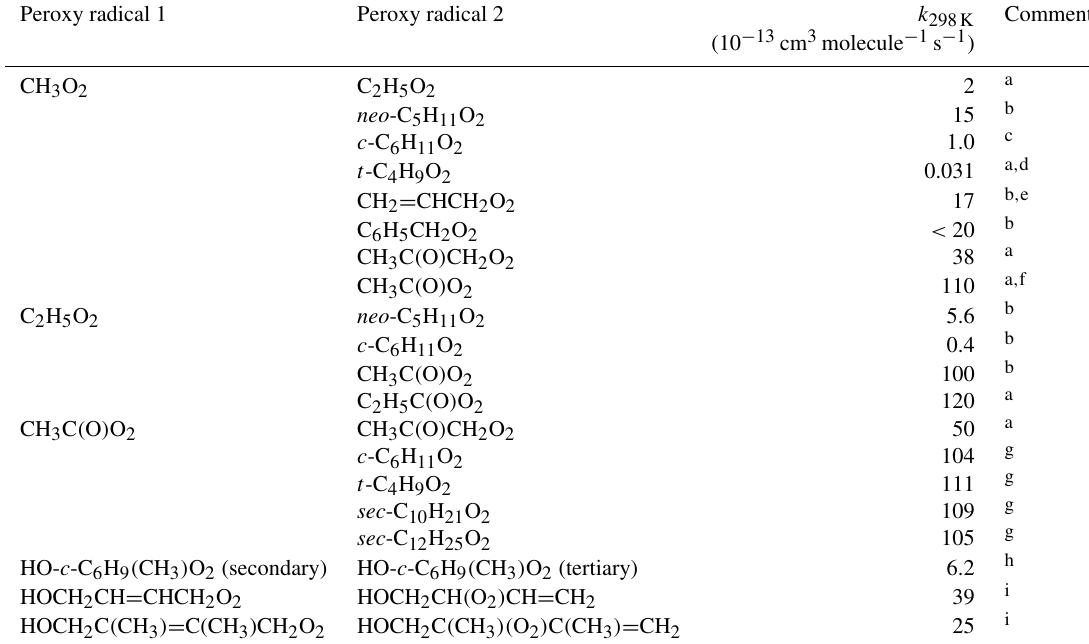
Table 11. Kinetic data for the cross-reactions of hydrocarbon or oxygenated peroxy radicals at 298K. Where available, the temperature dependence expression is given in the comments.